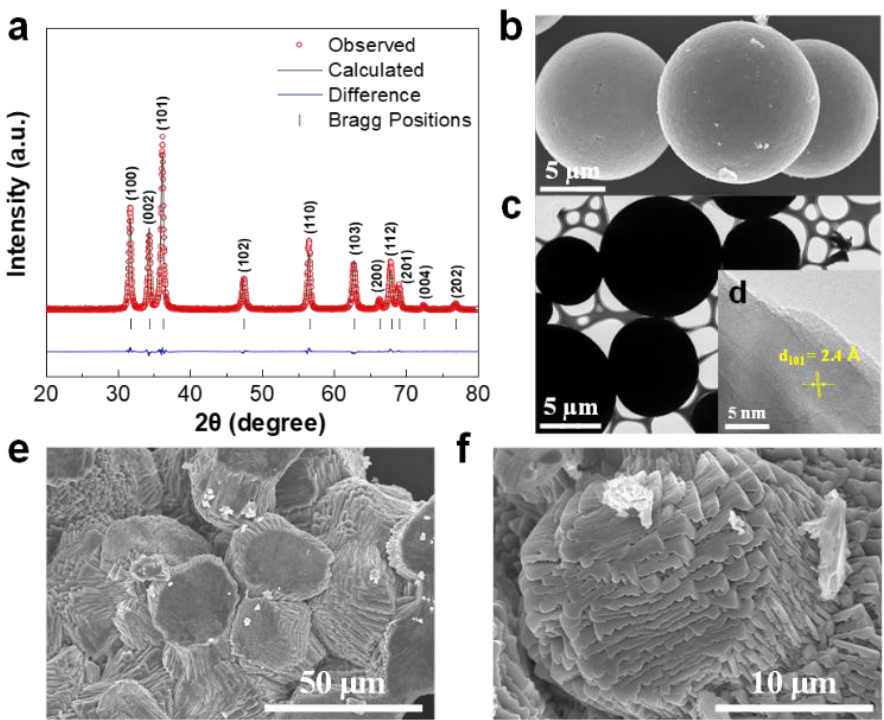
Figure 1. ( a ) XRD pattern of the as-synthesized ZnO microspheres, ( b ) FE-SEM image of ZnO microspheres, and ( c ) FE-TEM image of ZnO microspheres. Inset: ( d ) high-resolution TEM image of ZnO microspheres. FE-SEM image of ZnO microspheres treated with a ZMS solution for 1 h at ( e ) low and ( f ) high magnifications.